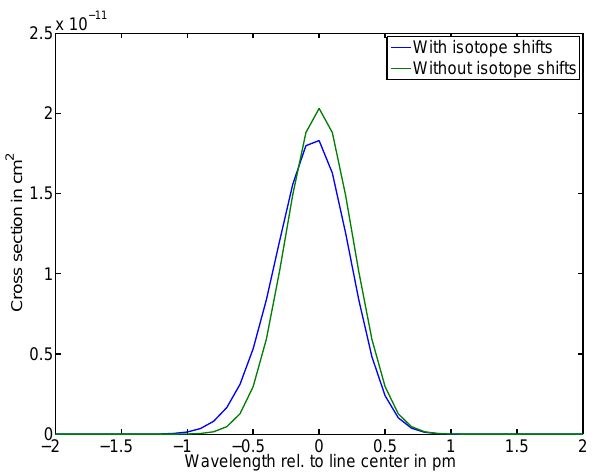
Fig. 18. Absorption cross section for the Mg 285.2nm line with and without considering isotopic shifts. The integrated cross section is the same for both cases. However, through the isotopic shifts for the heavier isotopes 25 Mg and 26 Mg, a part of the cross section is shifted from the center of the line to the edge of the line, which effectively reduces the absorption cross section for the integrated